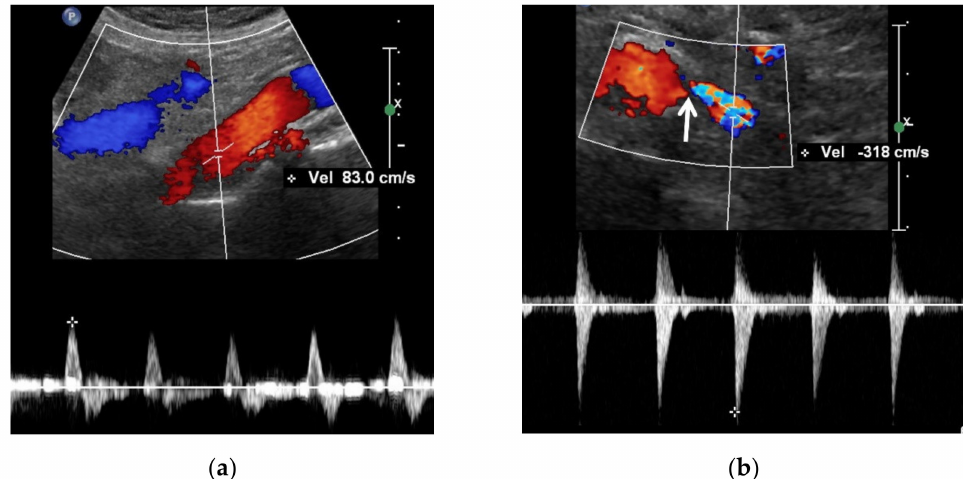
Figure 4. A high reno-aortic PSV ratio in a 78-year-old man. ( a ) Spectral Doppler US shows that a PSV is measured 83 cm/s 1–2 cm below the origin of superior mesenteric artery. ( b ) Spectral Doppler US shows that a PSV is measured 318 cm/s in the poststenotic area, showing turbulence flow. The frequency shift in the proximal left renal artery (arrow) is not sufficient to precisely quantify. The high-PSV RAR is more than 3.8 (318/83) because the PSV in the RAS should be higher than that in the poststenotic